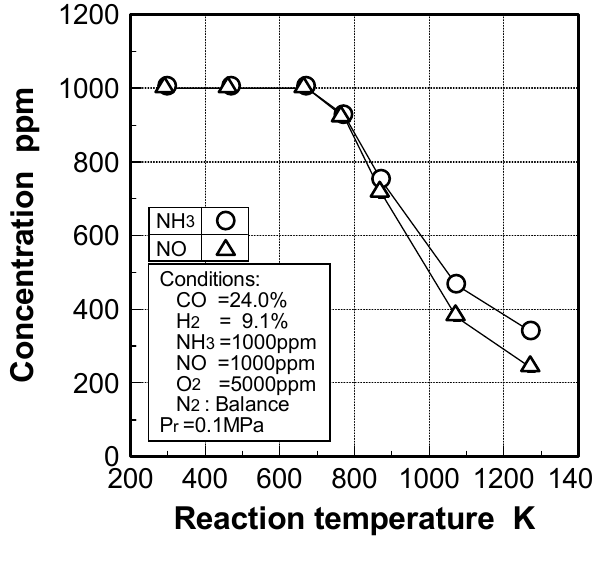
Figure 29. Effect of reaction temperature on decomposition of NH gasified fuel as defined by